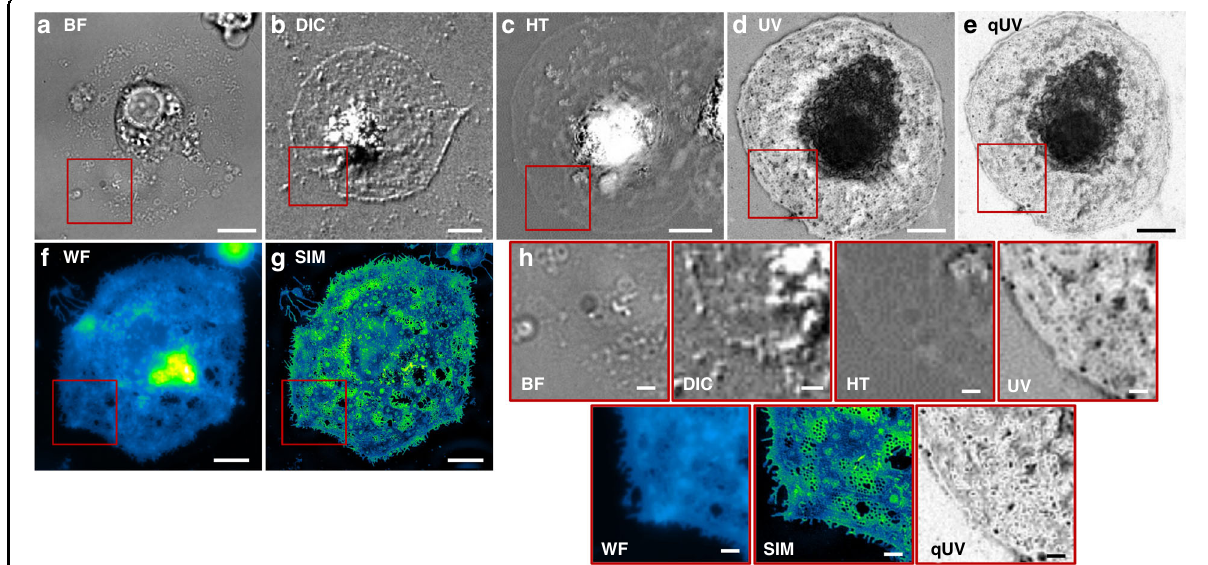
Fig. 3 LSEC micrographs. a – c Label-free imaging of fi xed LSECs using visible light bright fi eld (BF), differential interference contrast (DIC), quantitative holotomography (HT), and using our UV microscope ( d , e ) showing either a ( d ) raw UV intensity image or ( e ) quantitative UV extinction (qUV). ( f , g ) Fluorescence imaging of membrane-labeled LSECs using wide fi eld (WF) and superresolution structured illumination microscopy (SIM). h 2.5x enlarged views of similar regions. The scale bars are 5 µm in ( a – g ) and 1 µm in ( i ). Label-free images were computationally adjusted with unsharp masking for enhanced visibility of the sieve plate. Enlarged views of panels d and e are shown in Supplementary Fig.